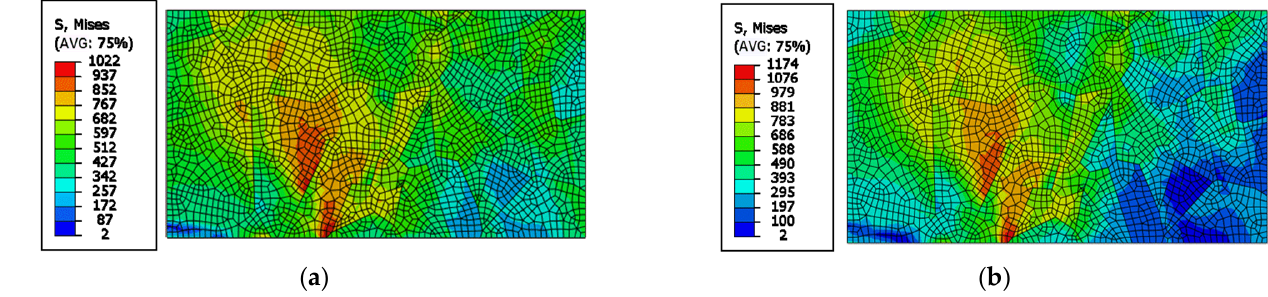
Figure 18. Stress result diagram of crack tip region under 43 kN load ( a ) − 20 °C; ( b ) − 100 °C.